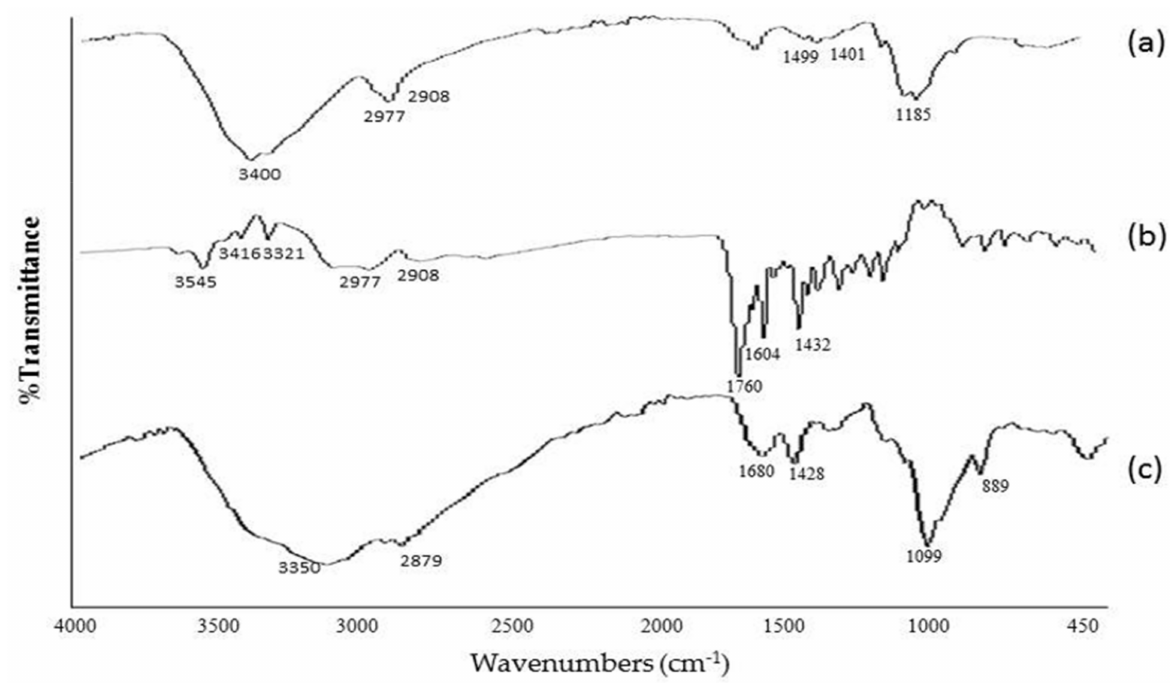
Figure 2. FTIR spectra of ( a ) pure chitosan, ( b ) pure FA, and ( c ) FA–CS conjugate.